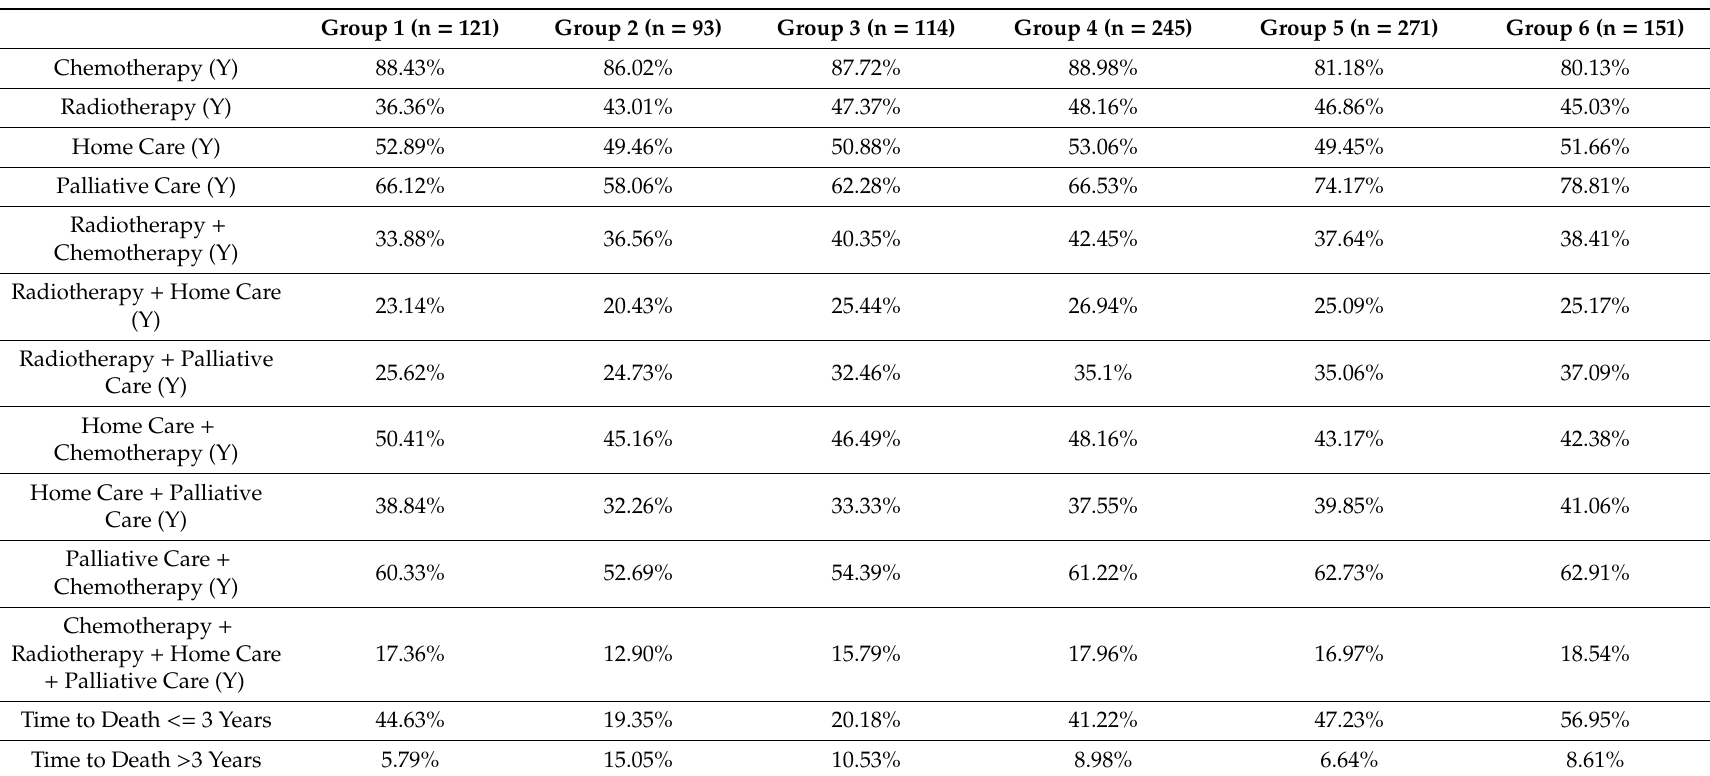
Table 5. Clinical parameters by trajectory group for adjusted